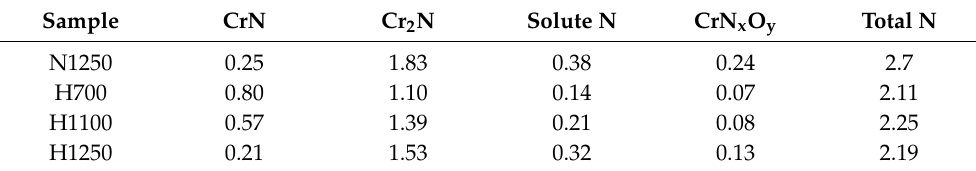
Figure 6. XPS peak convolution of CrN, Cr 2 N and solute N in the as-fabricated porous samples: ( a ) N1250; ( b ) H700; ( c ) H1100; ( d ) H1250. Table 6. Nitrogen content in different states for the porous HNASSs